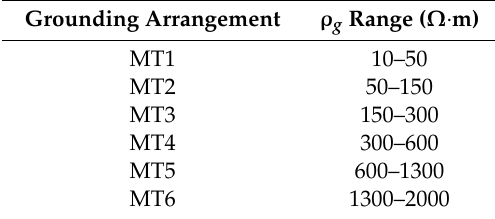
Table 2. Soil resistivity range for each grounding arrangement according to Terna unified design.